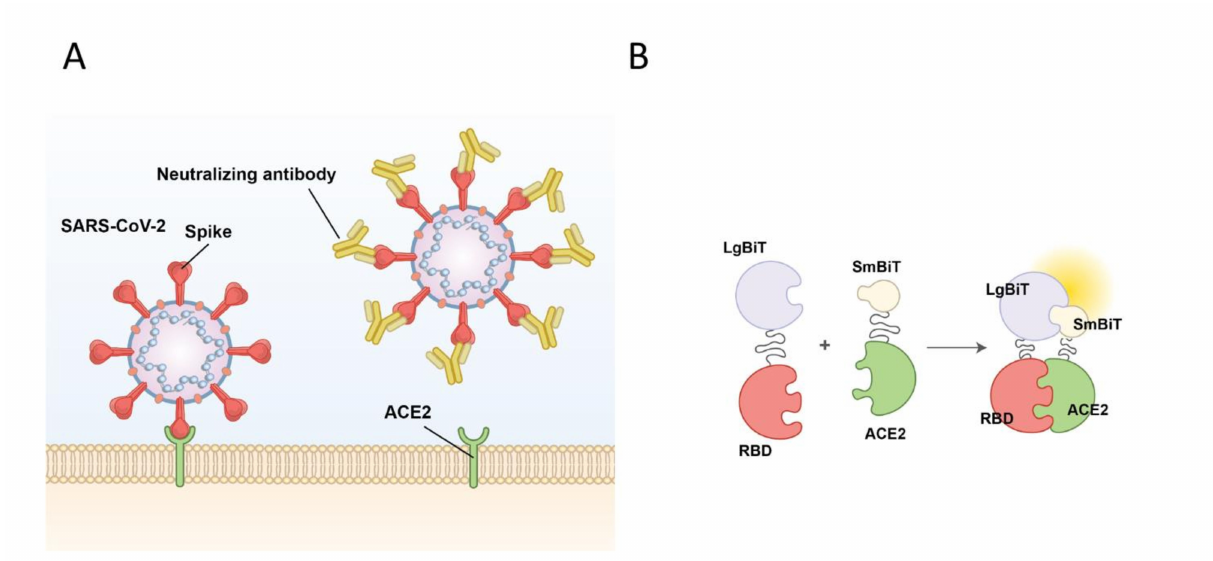
Figure 1. Schematic of SARS-CoV-2 viral entry and the NanoBiT biosensor. ( A ) Schematic of SARS-CoV-2 viral entry via the interaction between the receptor binding domain (RBD) of the spike glycoprotein and the host cell receptor angiotensin- converting enzyme 2 (ACE2). ( B ) Illustration of the NanoBiT complementation-based biosensor which detects interactions between RBD fused to Large Bit (LgBiT) and ACE2 fused to Small Bit subunit